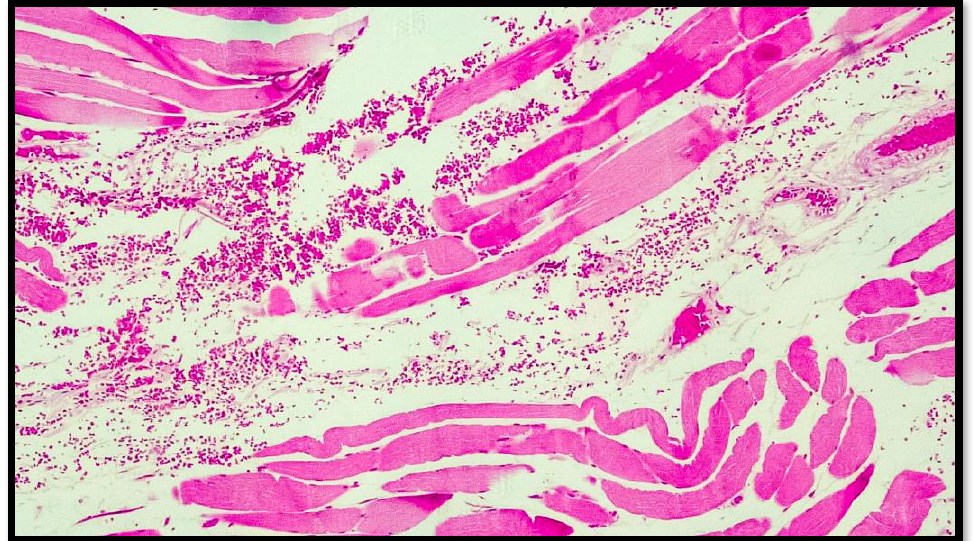
Figure 3. Histological preparation showing the presence of hemorrhagic infiltrate between the skeletal muscle fibers near the sternal insertion head of the sternocleidomastoid muscle. Note the presence of misalignment between the muscle fibers due to the mechanical traction force (hematoxylin–Eosin, Diapath S.p.A.). Original magnification, 4×.